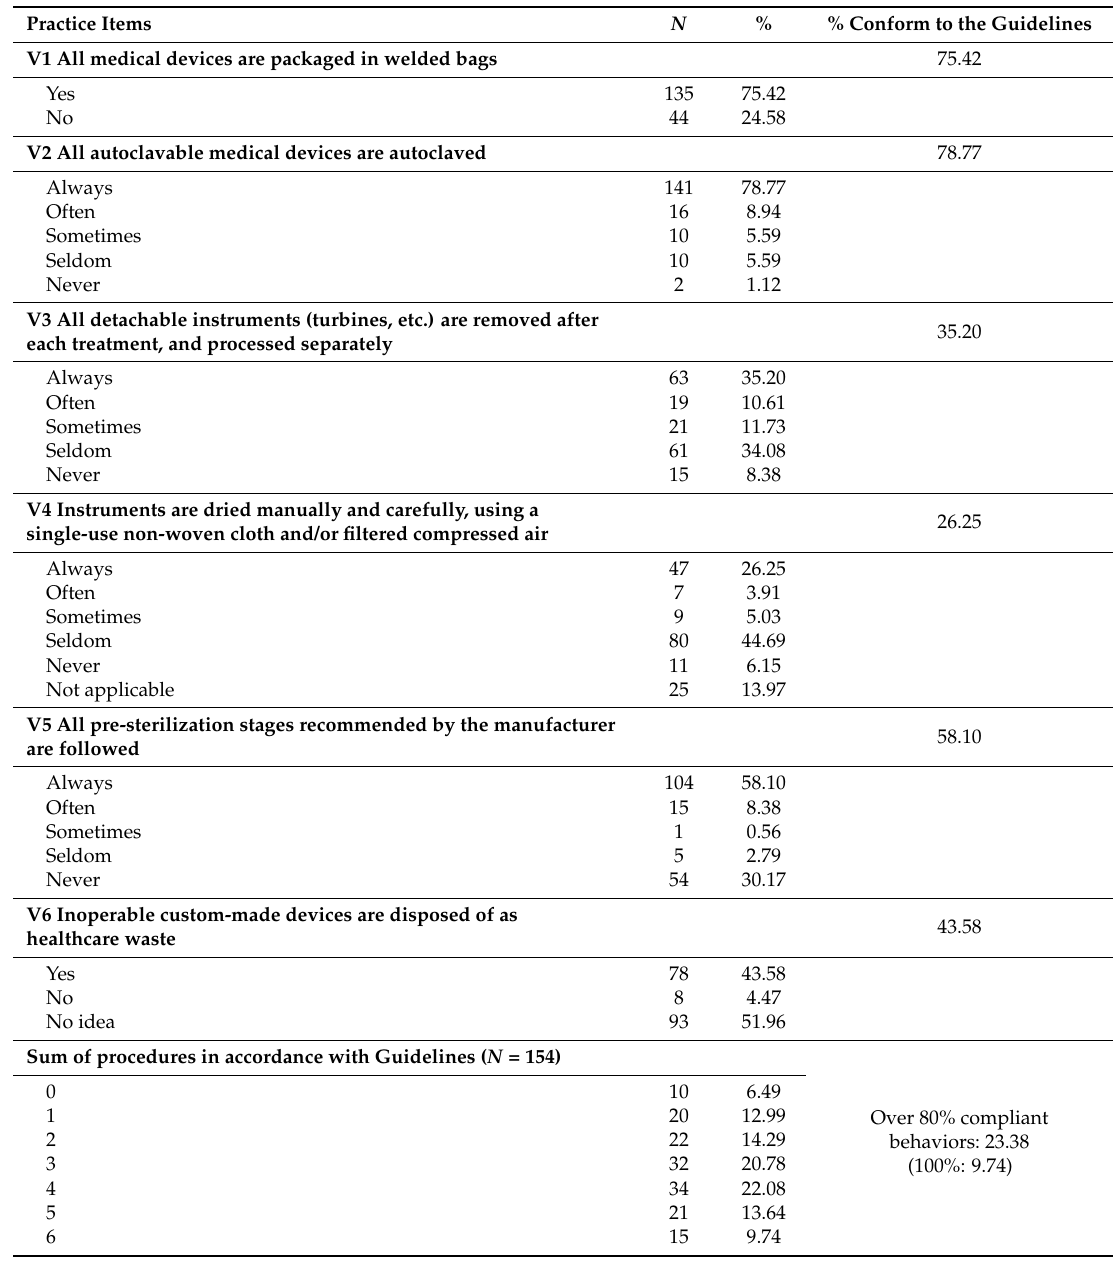
Table 1. Descriptive analysis: Conformity with sterilization-related procedures (Group 1) ( N =